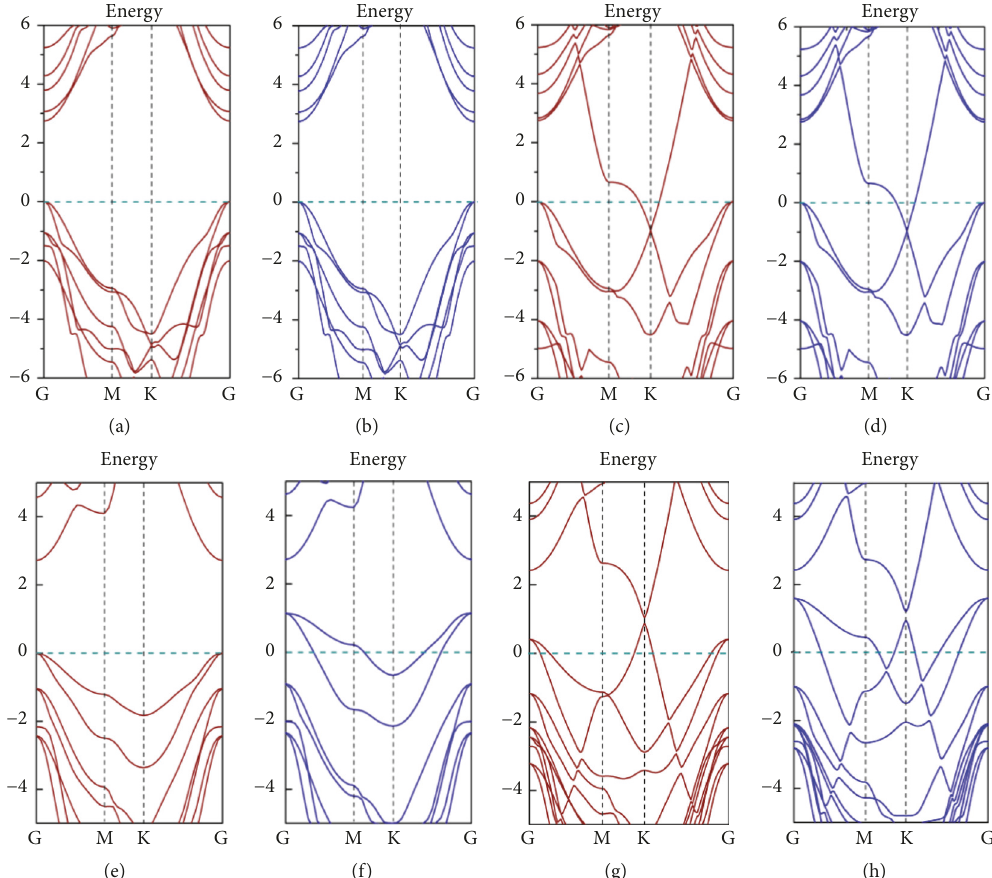
Figure 3: The electronic band structure of an (a, b) H-terminated diamond (111) surface, a (c, d) GHD system, an (e, f) O diamond (111) surface, and a (g, h) GO D system. The (a), (c), (e), and (g) figures represent spin-up states, and the (b),(d), (f), and (h) ontop figures represent spin-down states. The Fermi level is set to zero and is marked by dashed lines at zero energy.